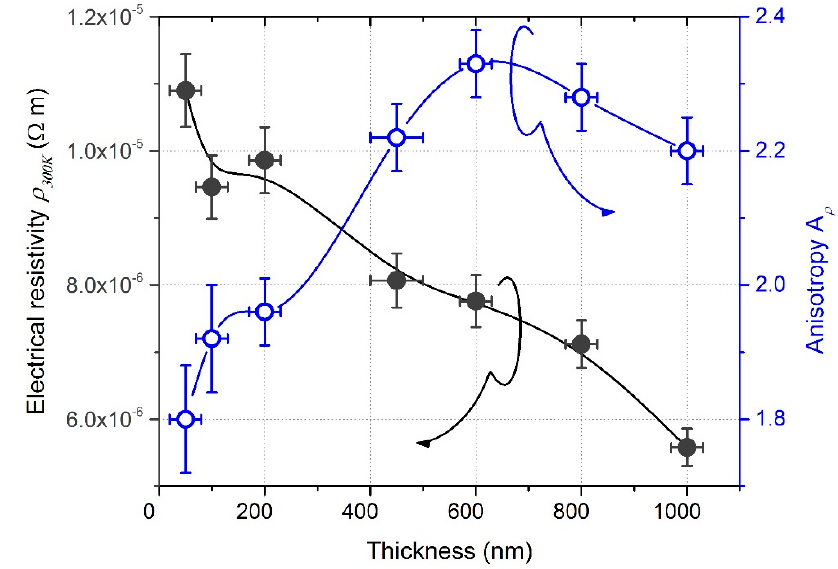
Figure 4. DC electrical resistivity and anisotropic resistivity measured at room temperature (300 K) as a function of the film’s thickness.